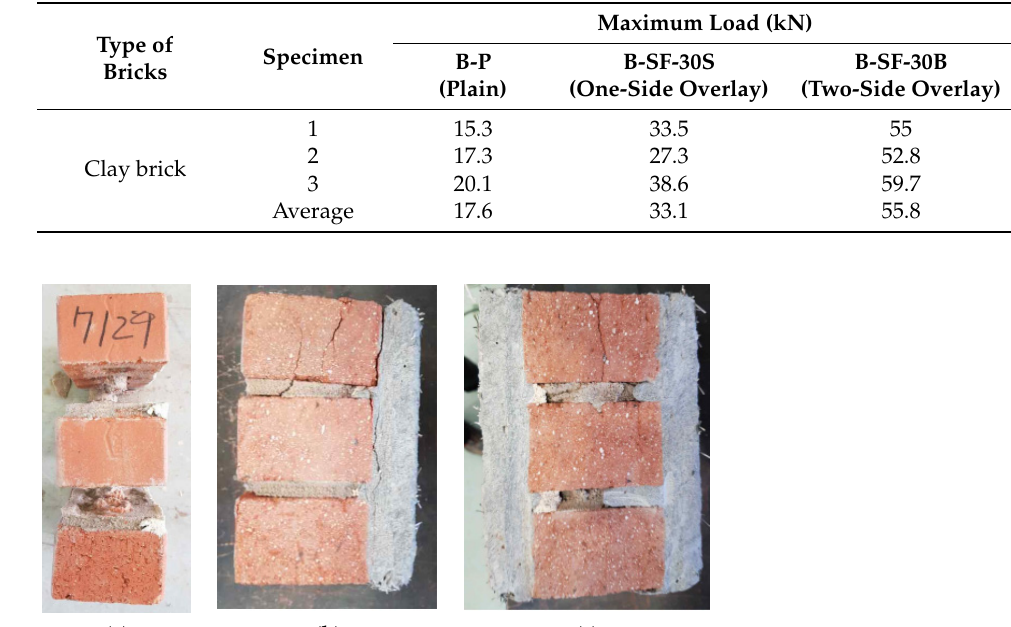
Table 6. Bond strength test results for masonry prisms.